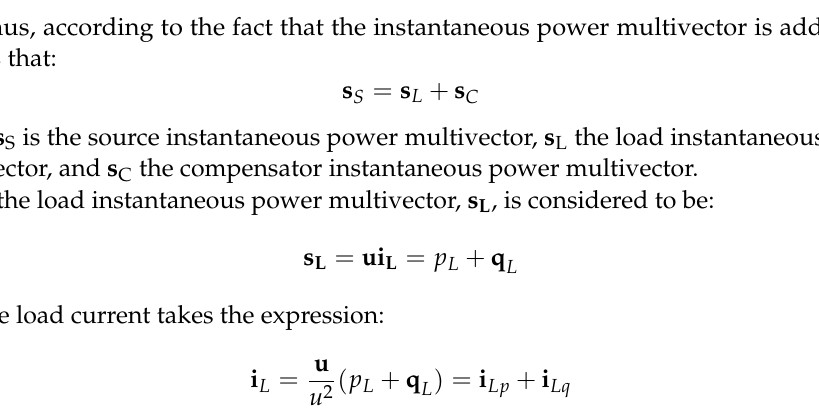
Figure 3. Multi-phase power system with a shunt compensator.